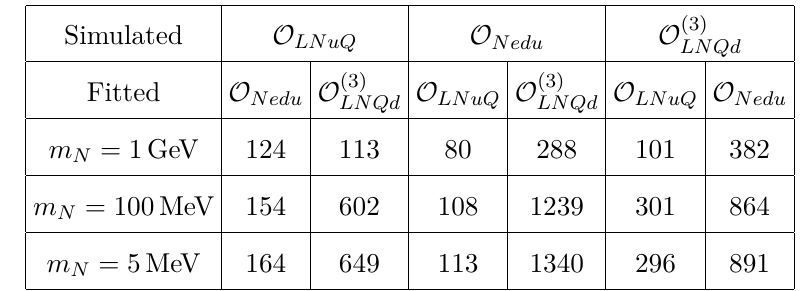
Table 8 . Distinguishing between production operators using three-body B decay. χ 2 cos θ ‘ distributions with different simulated and fitted production